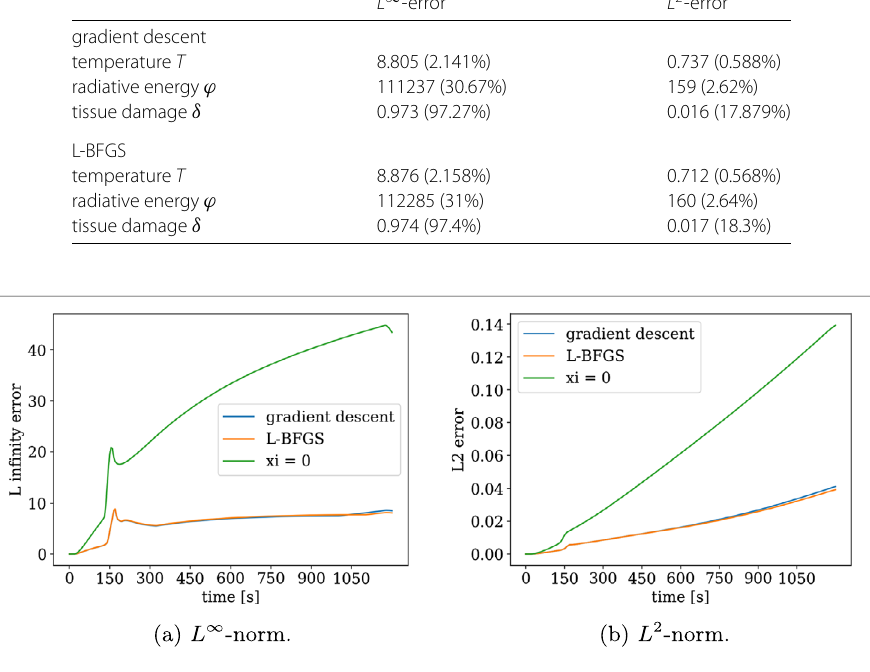
Instead, the vessels are more “smeared out”. However, we can still observe that we have three peaks in the perfusion rate, corresponding to the vessels in the middle of the first column for the desired perfusion rate. Additionally, we can observe that the middle one of these three shows a higher perfusion rate, as it is the case for the synthetic blood perfu- sion (cf. Fig. 2b). We also observe that both methods underestimate the perfusion rate by about 20%. This is due to the effect of the regularization term that penalizes large values of ξ